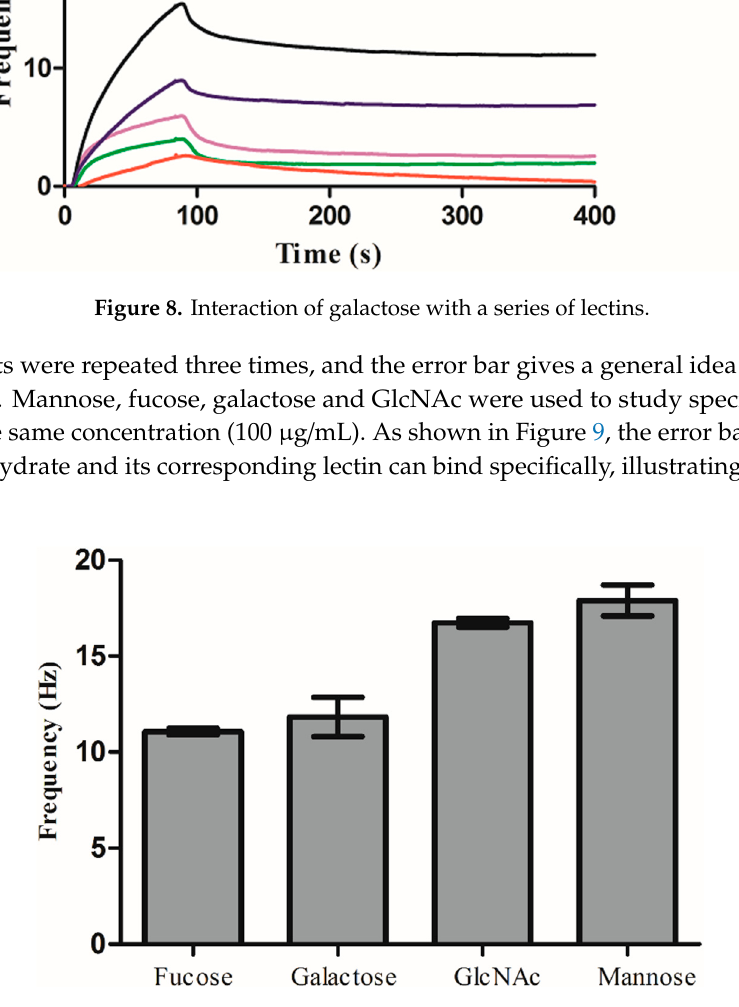
Figure 9. Error bar results of the four underivatized carbohydrates.